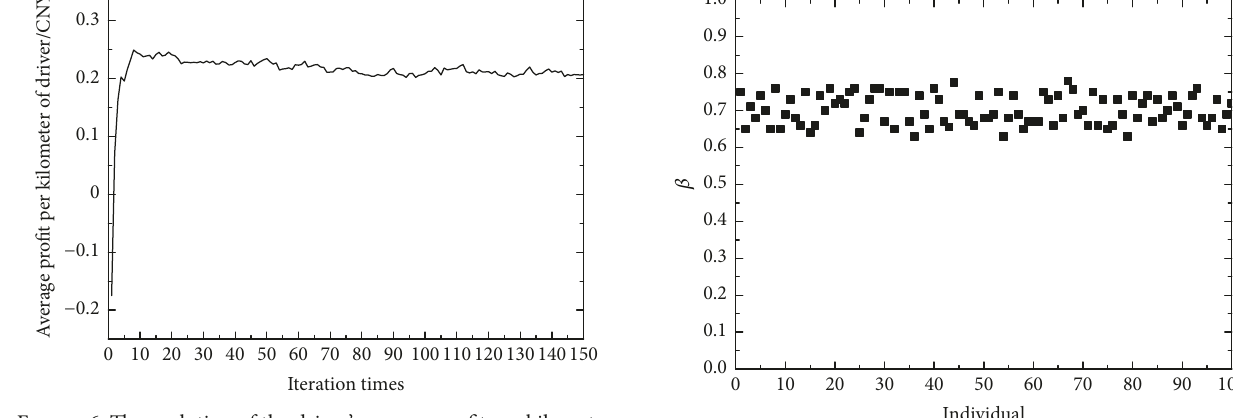
Figure 6: The evolution of the driver’s average profit per kilometer.